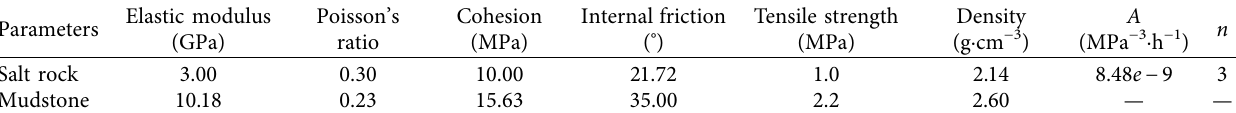
Table 1: Basic mechanical parameters of salt rock and mudstone.